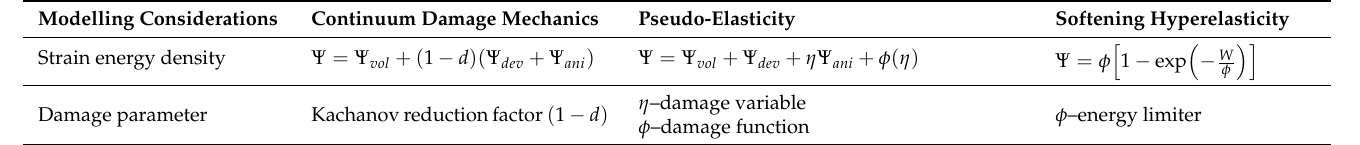
Table 1. Summary of damage modelling